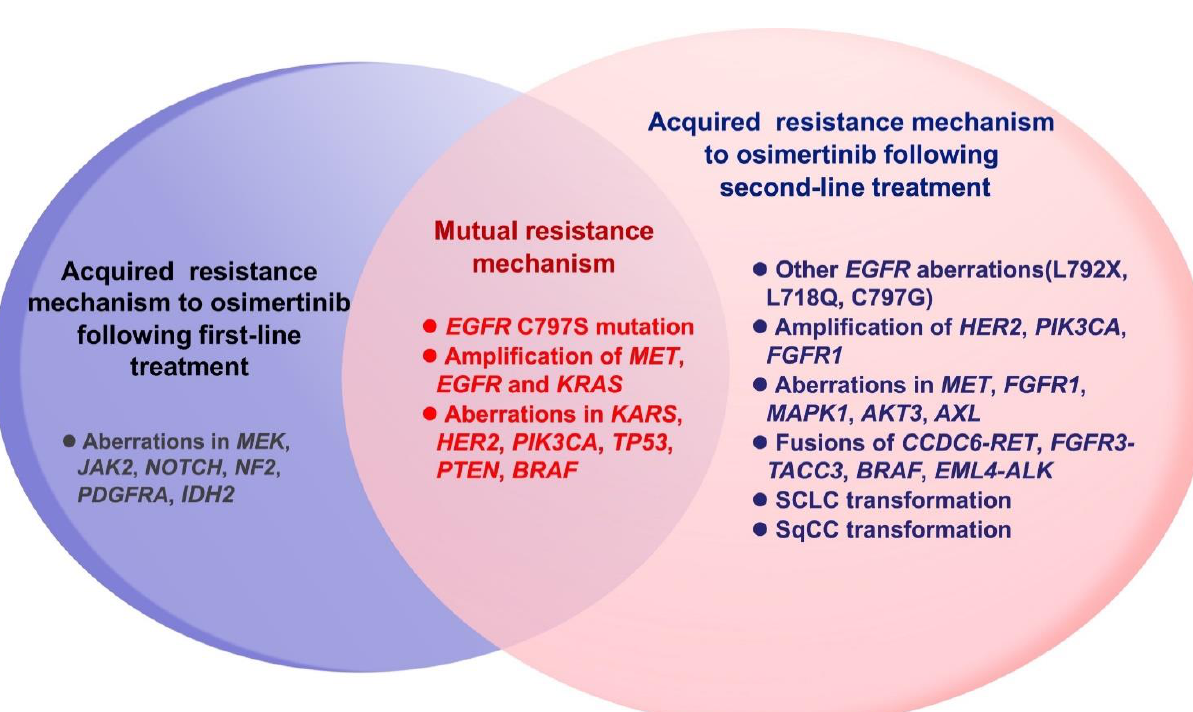
Figure 4. Difference of acquired resistance mechanisms between first-line ( A ) and second-line ( B ) treatment of third-gen- eration TKI osimertinib. Adapted from [76,77], published by Future Medicine, 2018 and Elsevier, 2018